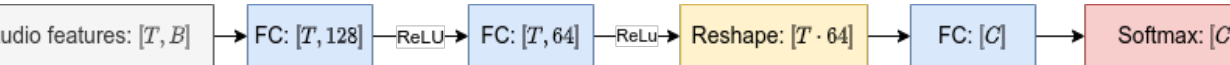
Figure 2. The scheme of the feedforward neural network used in our experiments. The shape of the resulting tensor is specified after each block in square brackets. FC stands for the fully-connected layer. T is the number of frames in a sample (98 in all our experiments). B is the number of channels in the audio features (80 for log-mel filterbanks, 512 for wav2vec features). C is the number of classes to discriminate.